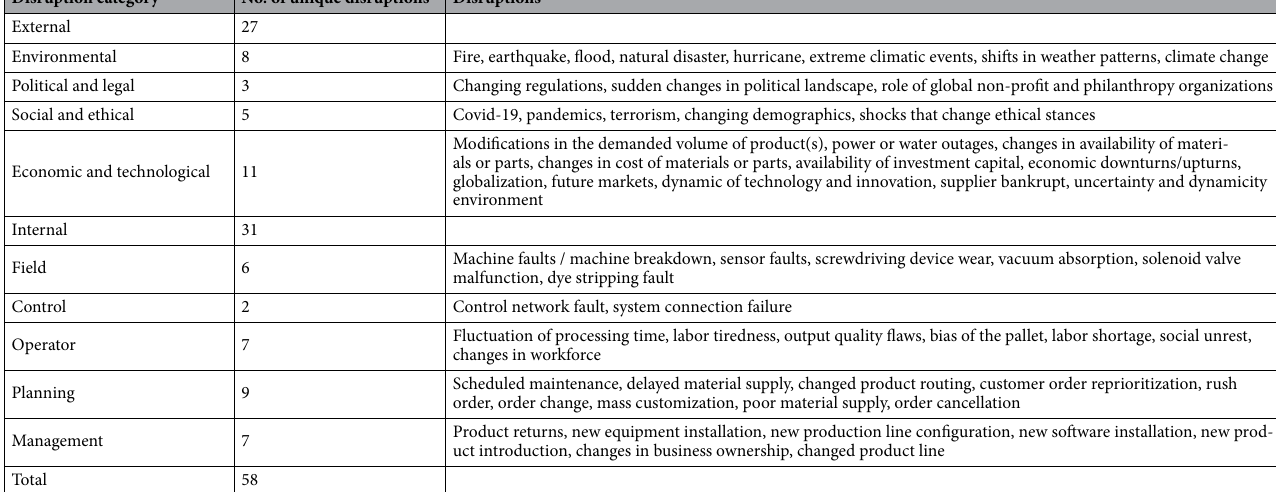
Table 3. Mentioned unique disruptions based on category.